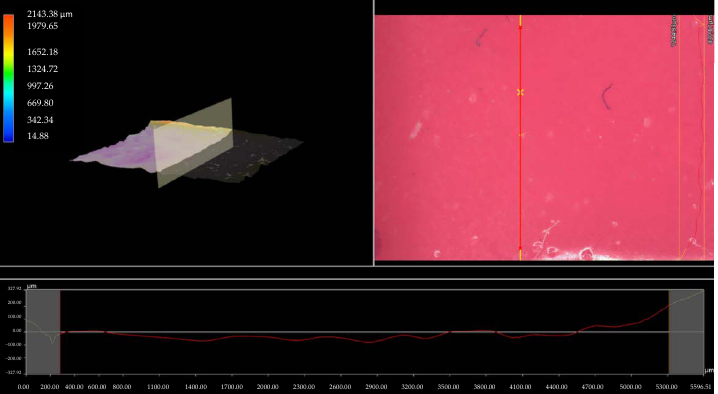
Figure 8. 3D view and the roughness profile (along the red line) of sample 700/12.5.